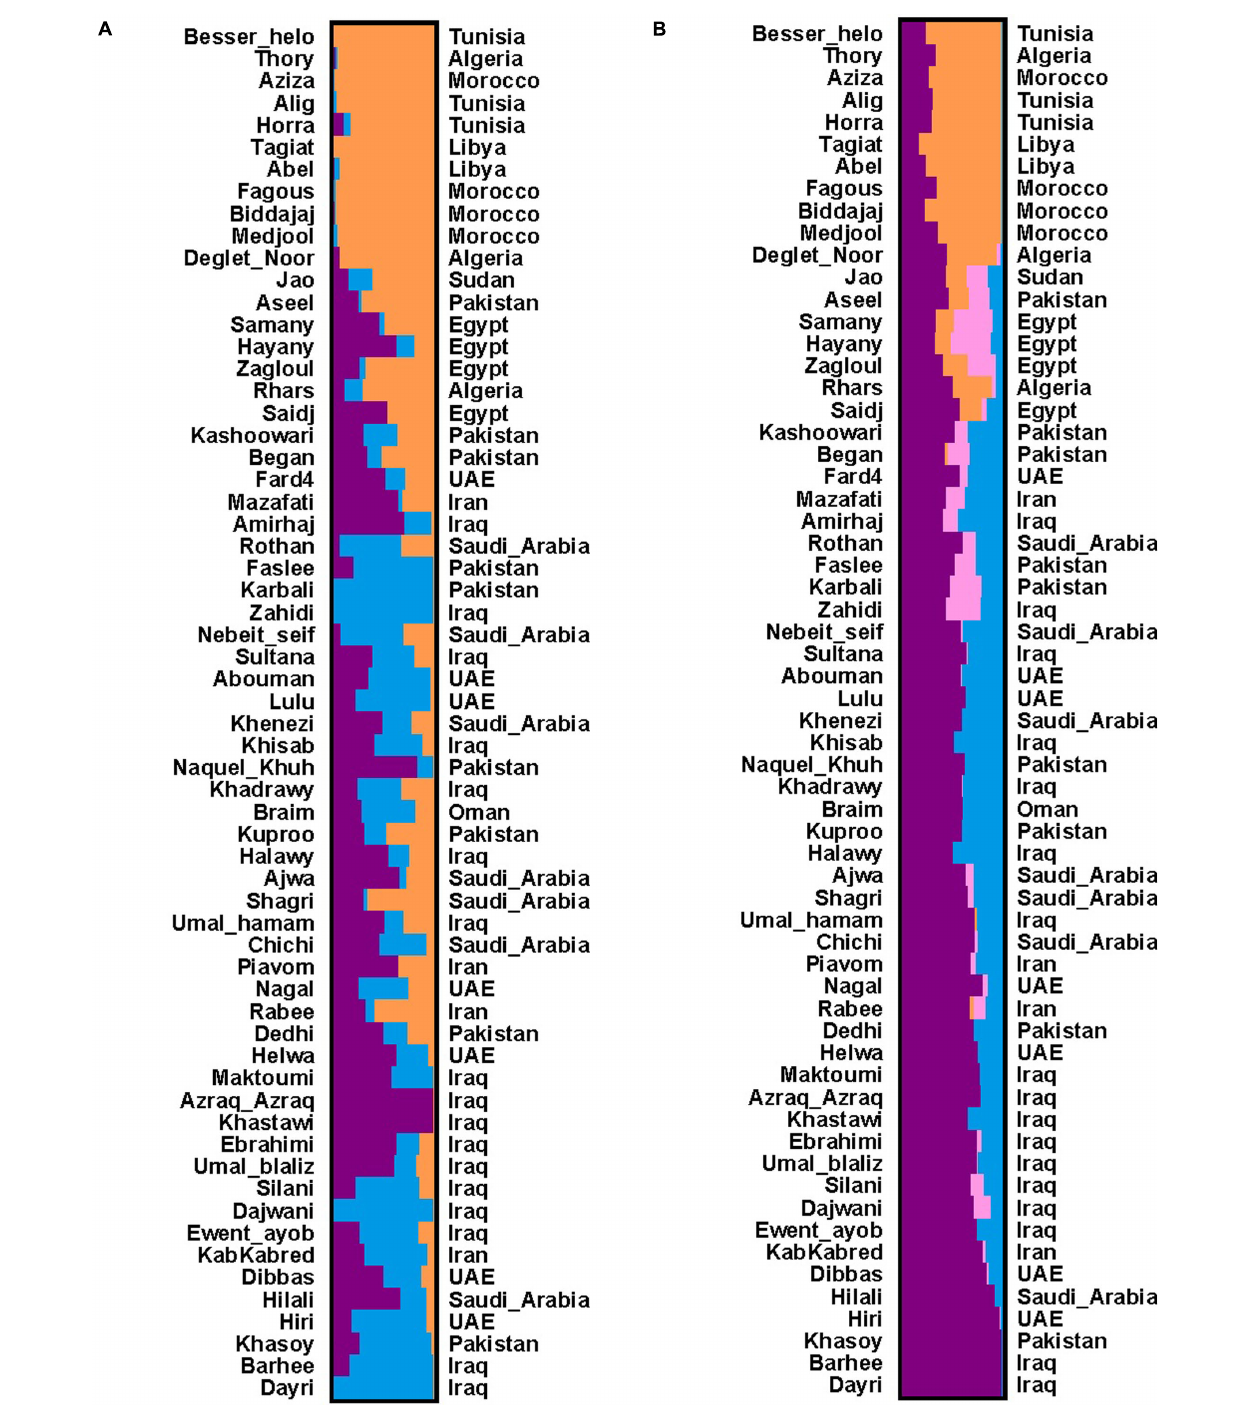
Frontiers in Plant Science |